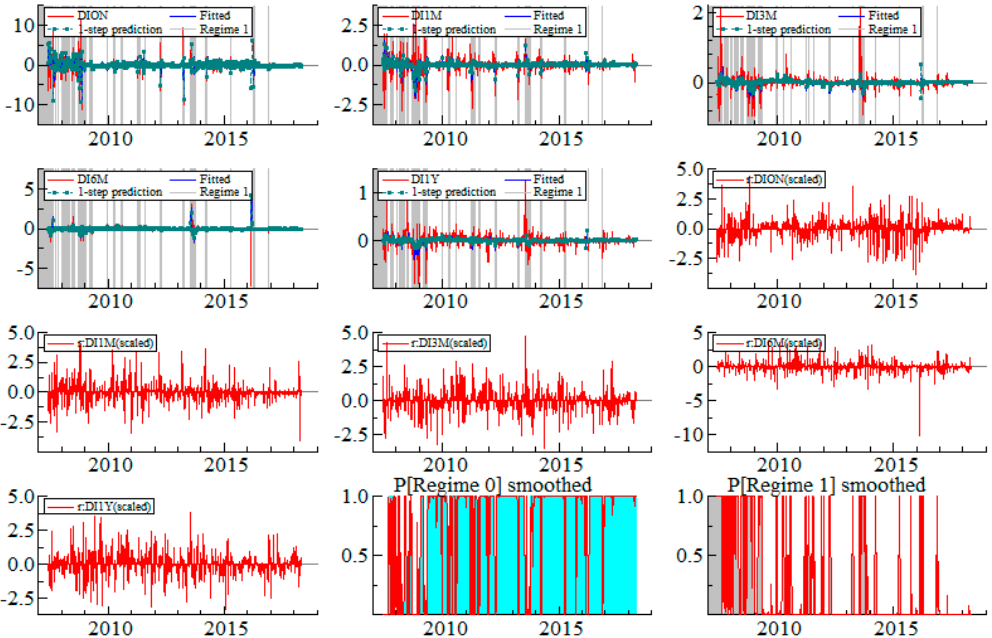
Figure A7. India Regime-switching modeling: Msiah (2)-Vecm (1). Note: Regime 1 denotes the high-volatility regime, whilst Regime 0 the low-volatility one [8,25].